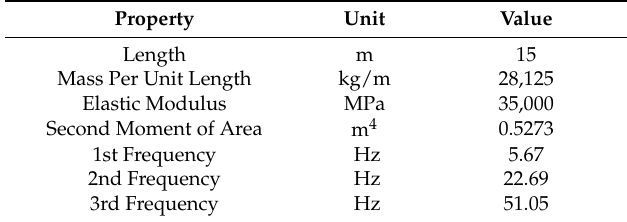
Table 3. Properties of the bridge.